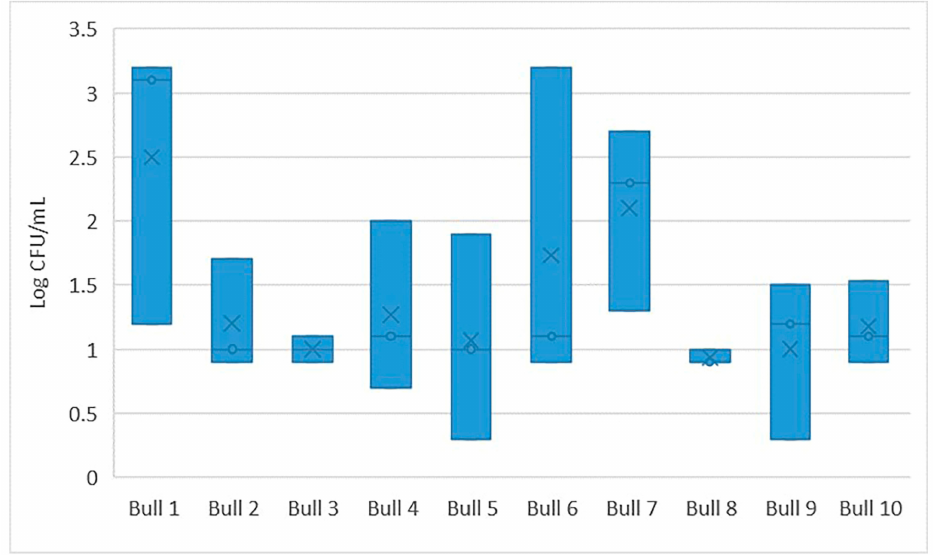
Figure 1. Number of bacteria (Log CFU/mL) in control samples ( n = 3) for individual bulls at Time 1.